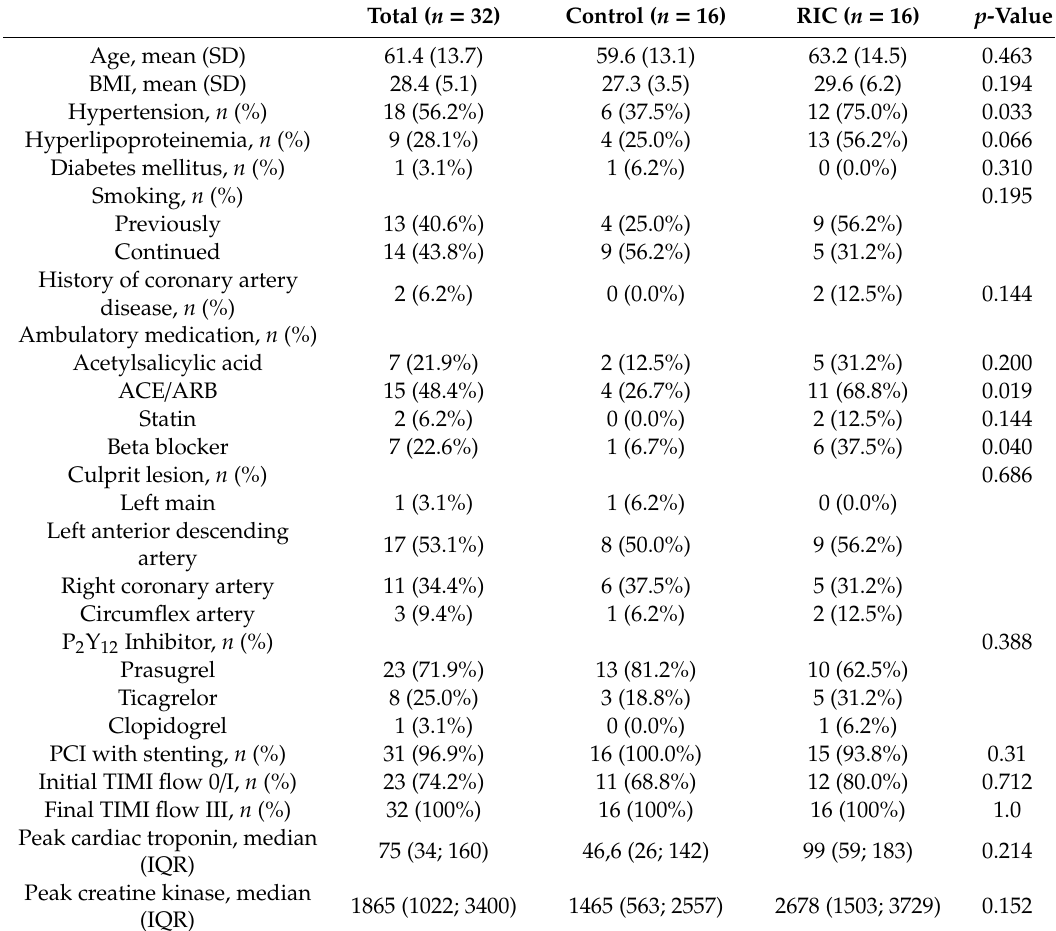
Table 1. Baseline characteristics of included